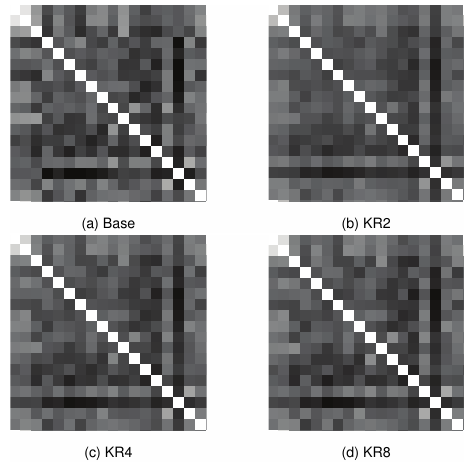
Fig. 2. Correlation matrices. Base vs KR